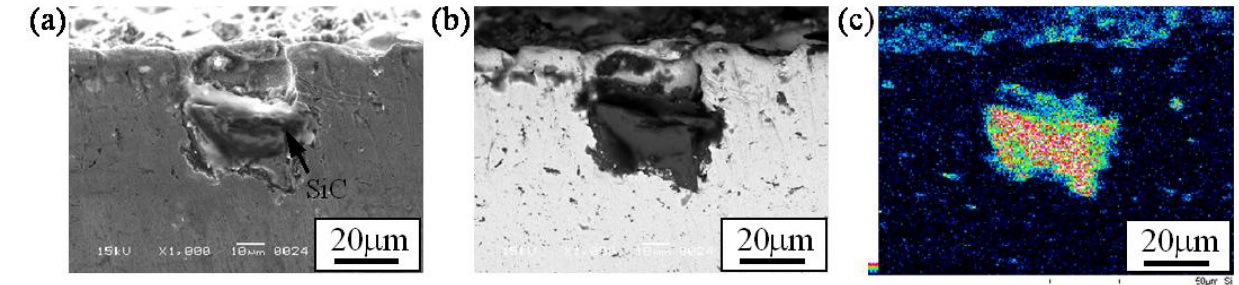
Figure 10. Microstructure around a SiC particle in Specimen 2. (a) SE Image, (b) Compo Image and (c) Si distribution map by EDX [17].